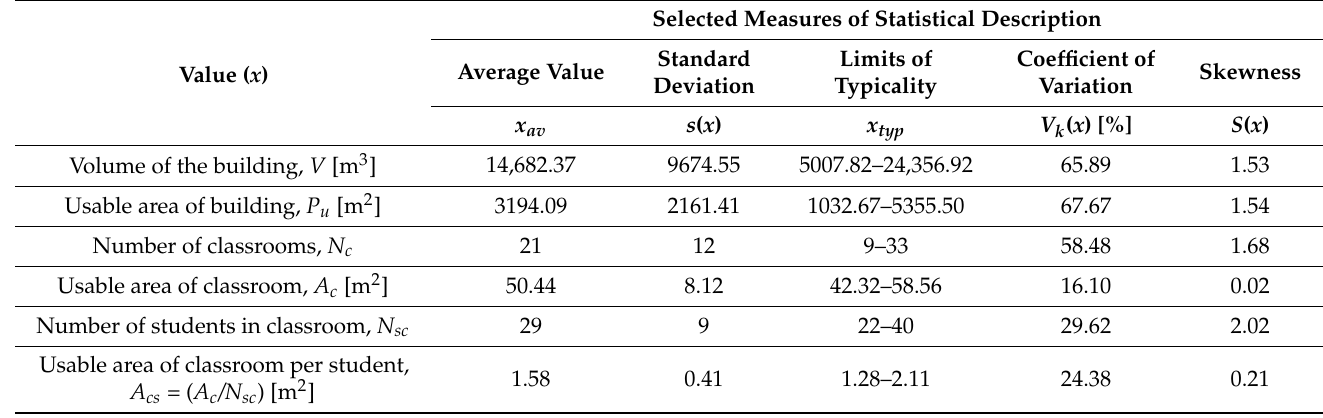
Table 2. Selected measures of statistical description for the values characterizing classrooms in 50 education